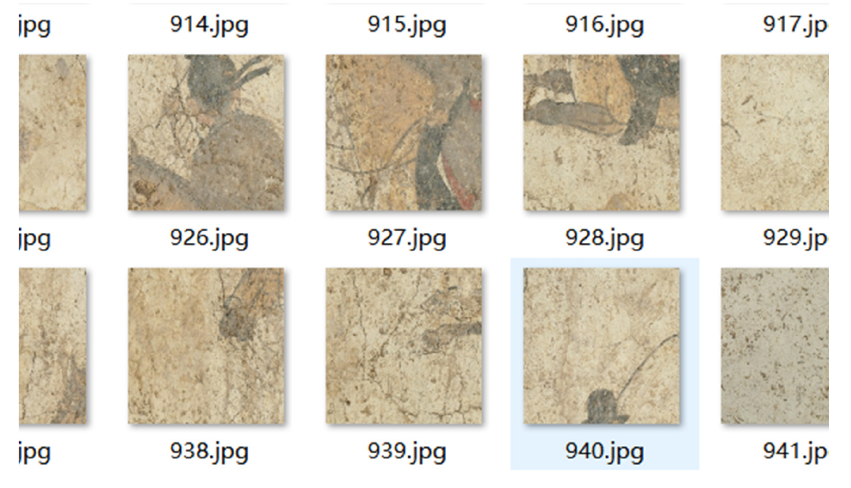
Fig. 7 The training mural image database